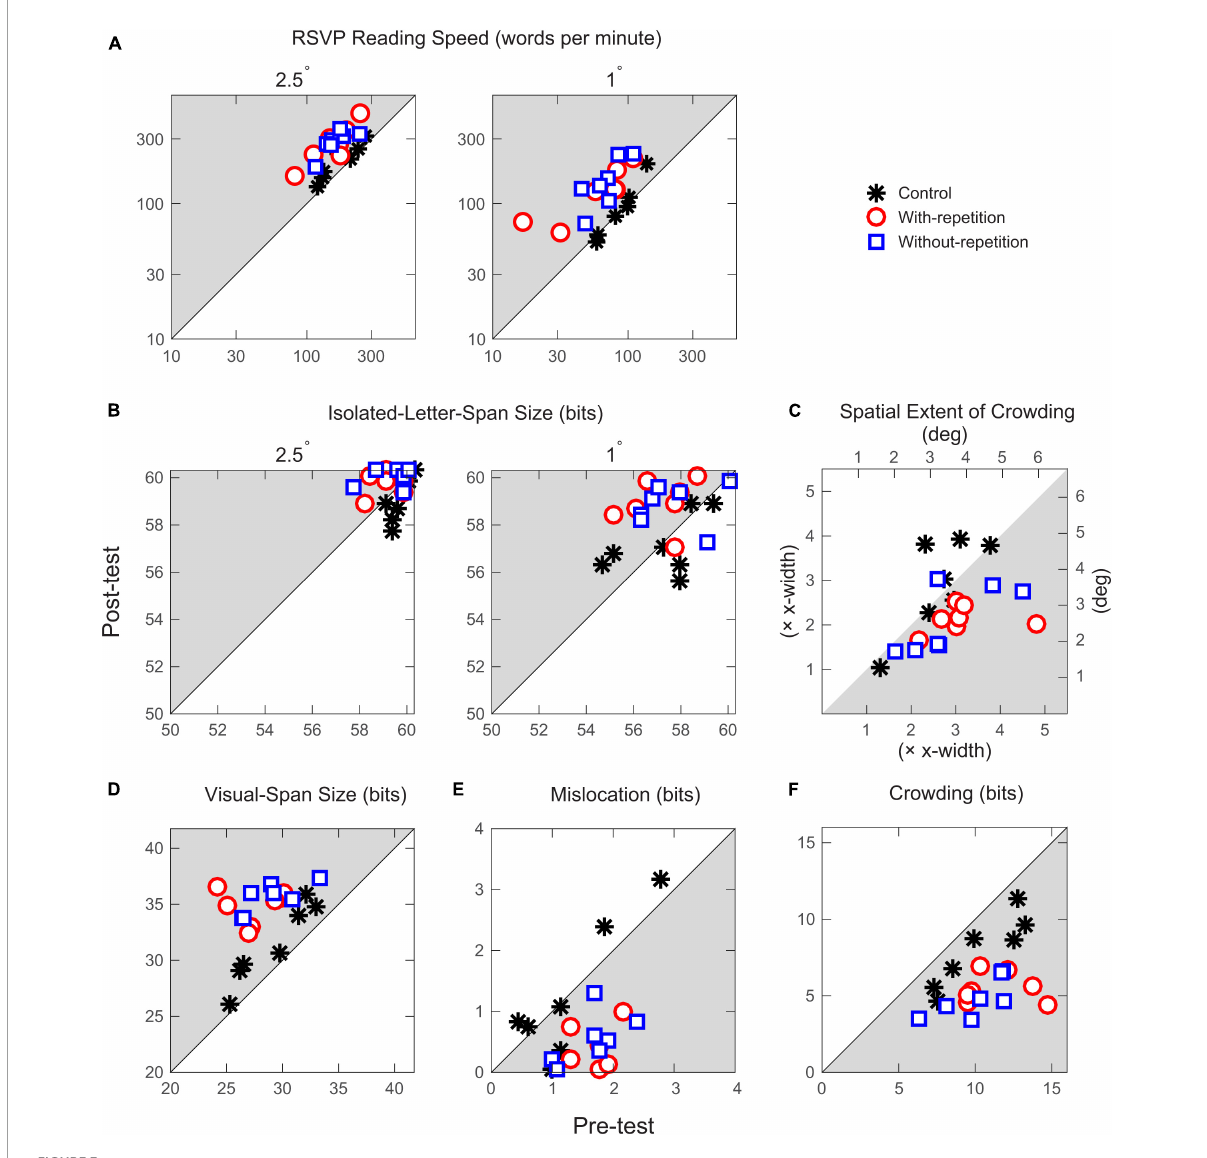
FIGURE3 Scatter plots of post-test performance vs. pre-test performance for the three observer groups. (A) Rapid Serial Visual Presentation (RSVP) reading speeds at 2.5 ◦ and 1 ◦ print sizes. Each data point represents one observer. Points on the diagonal line imply no change between the pre- and post-tests. Data points lying inside the shaded region indicate improved performance in the post-test. (B) The size of the isolated-letter span at 2.5 ◦ and 1 ◦ print sizes. The maximum possible amount of information transmitted through 13 letter positions is 60.31 bits. (C) Spatial extent of crowding. The top horizontal scale and the right vertical scale show conversion from multiples of x-width to degrees. (D) The size of the visual span. The maximum possible amount of information transmitted through nine letter positions is 41.75 bits. (E) Mislocation-induced information loss. (F) . Crowding-induced information